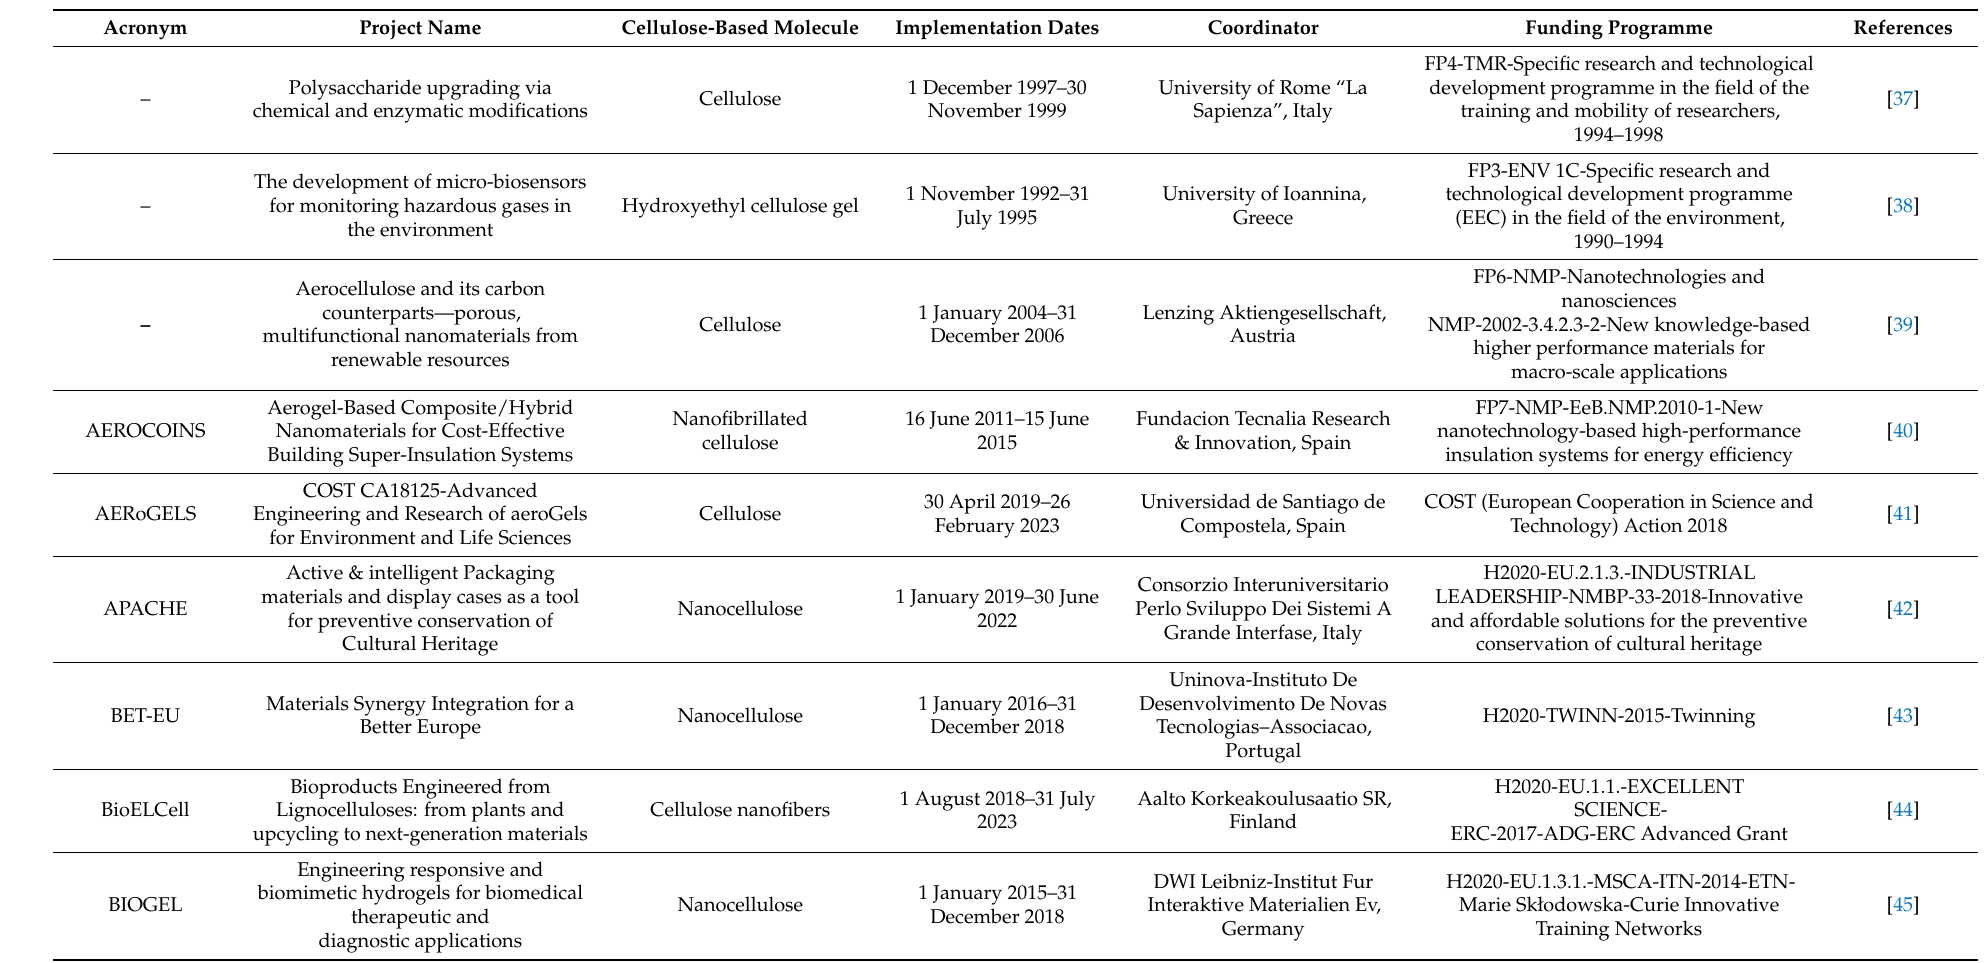
Table 2. International research projects on cellulose-based aerogels and